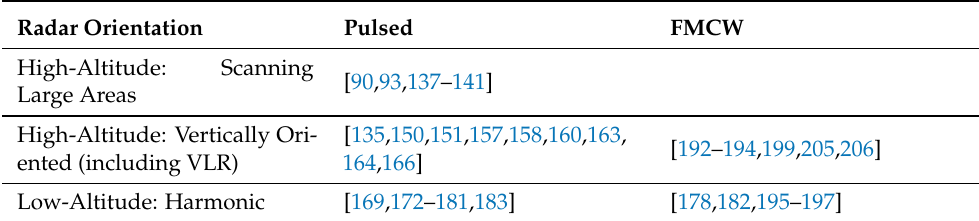
Table 2. Insect radar groups and relevant sample publications (not a complete